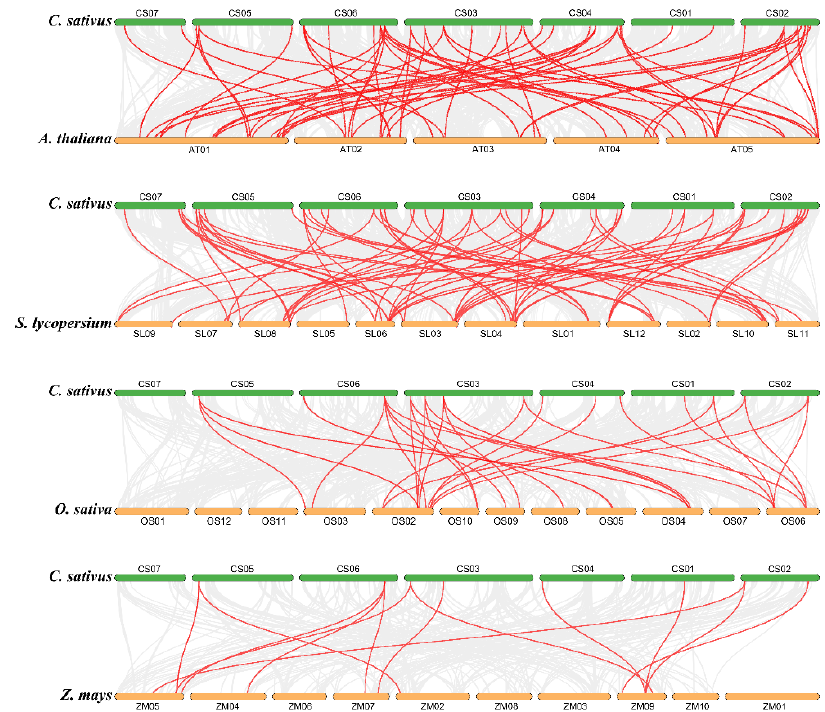
Figure 6. Synteny analysis of DREBs between cucumber and other plant species: The collinear blocks are marked by gray lines, while the collinear gene pairs with DREB genes are highlighted by red lines. ‘ C. sativus ’, ‘ A. thaliana ’, ‘ S. lycopersicum ’, ‘ O. sativa ’, and ‘ Z. mays ’ indicate Cucumis sativus , Arabidopsis thaliana , Solanum lycopersicum , Oryza sativa , and Zea mays , respectively.